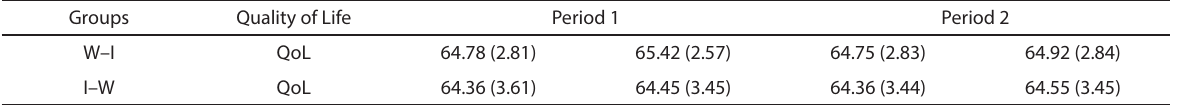
Table 4. Quality of life questionnaire results of the subjects - Mean (SD)